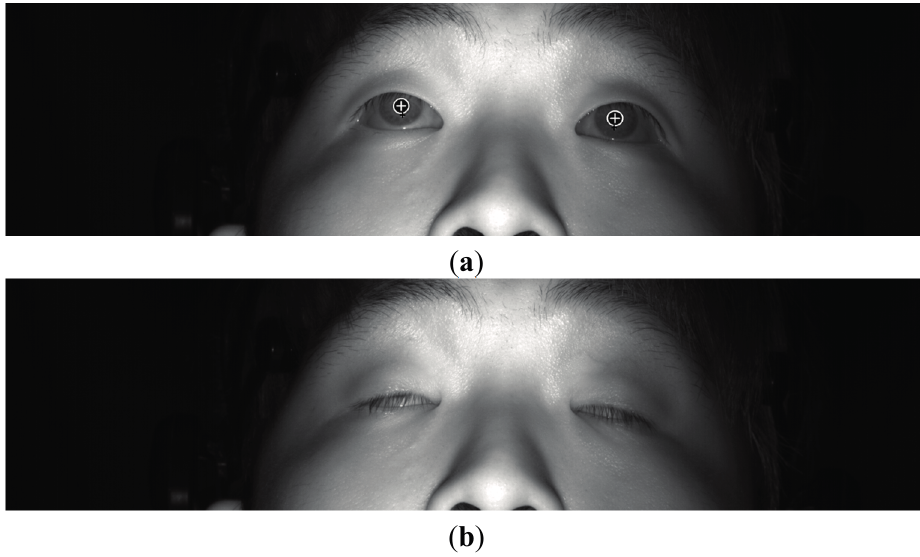
Figure 10. Example of determining whether eyes are open and closed. ( a ) Open eyes; ( b ) closed